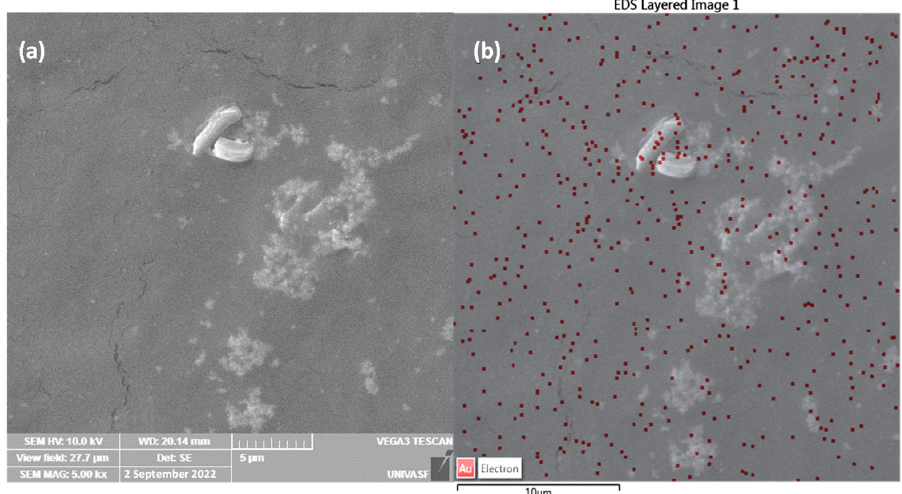
Figure 2. ( a ) SEM image of aggregates of Tanfloc decorated with synthesized gold nanoparticles and ( b ) overlaid EDX images of gold element (red dots) in captured SEM image.